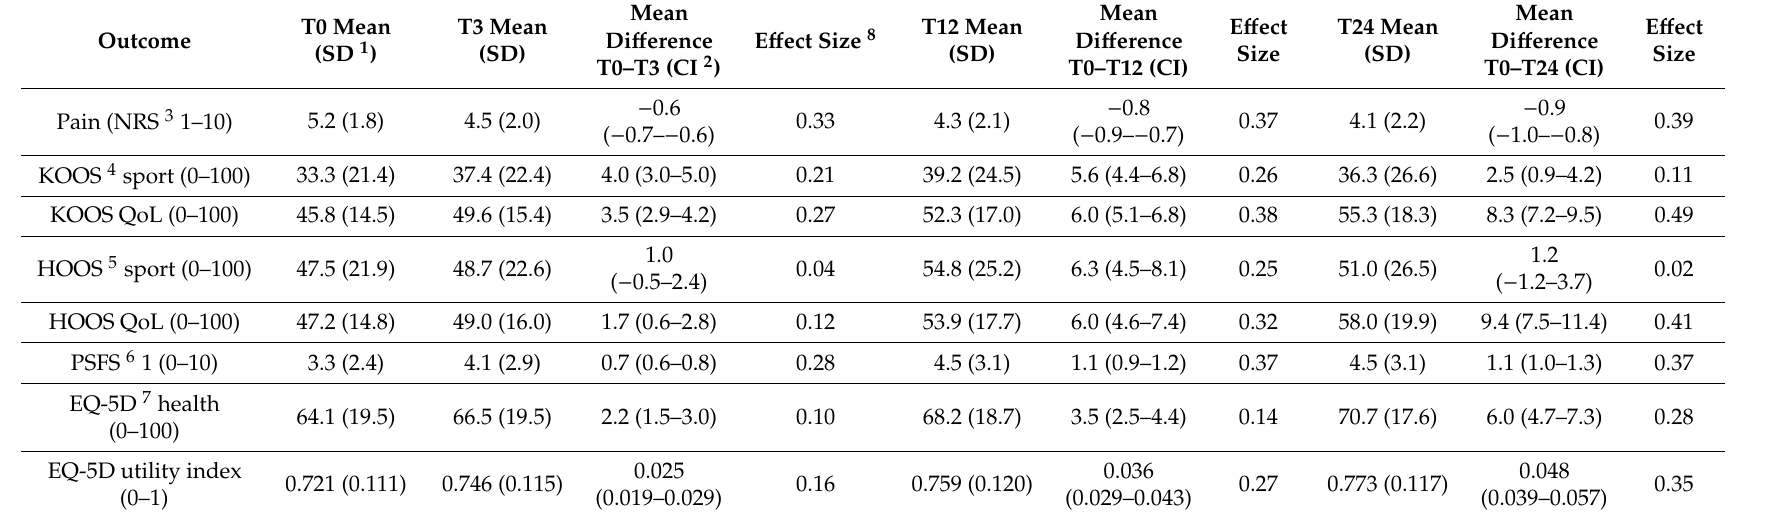
Table 3. Mean di ff erences (SD) between baseline (T0) and 3 (T3), 12 (T12) and 24 (T24)-month follow-up,